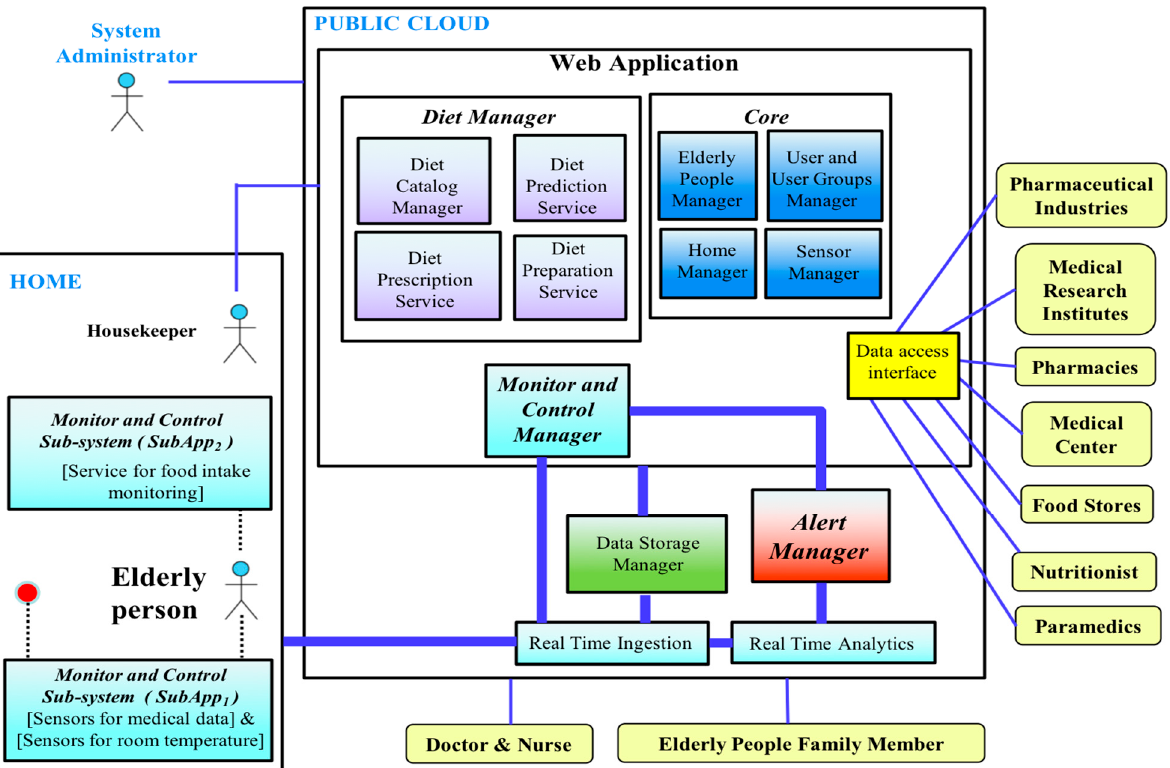
Figure 4. Functional view.